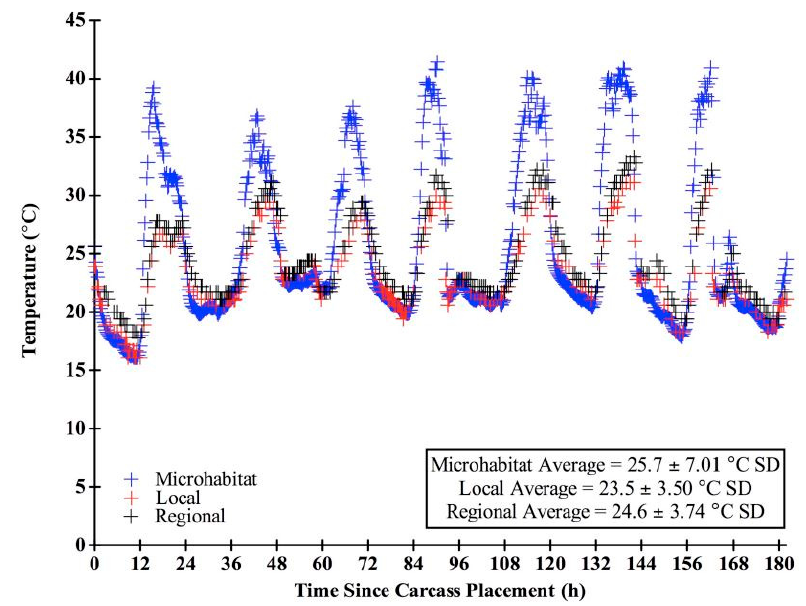
Figure 3. Temperature (°C) throughout decomposition for the microhabitat, local, and regional sources. Microhabitat data points are every 15 min while local and regional data points represent hourly temperatures.